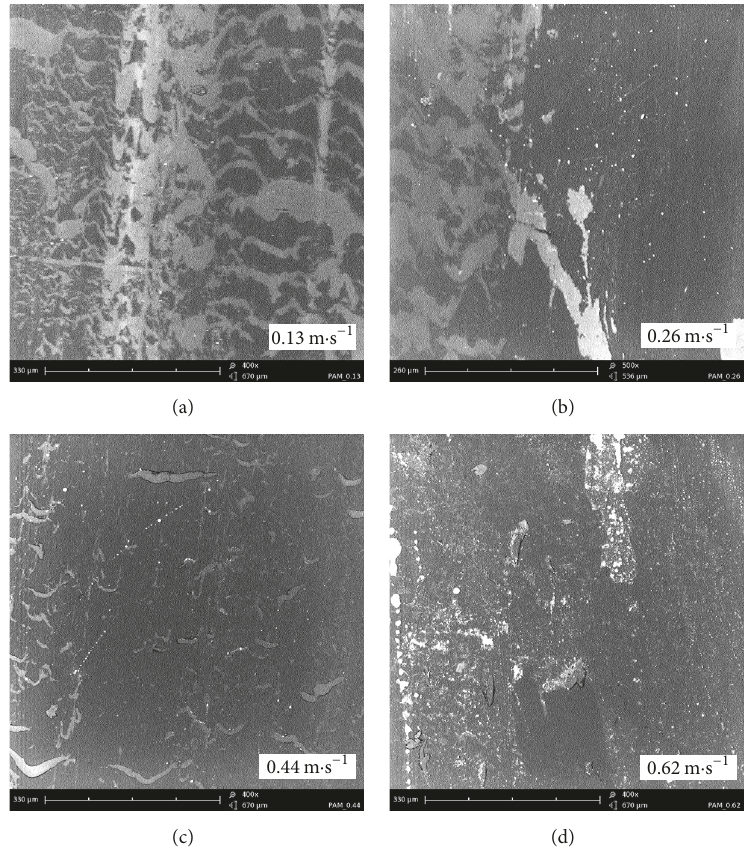
Figure 12: Effect of sliding velocity on worn surfaces of the investigated PA MoS 2 : ((a), (b), and (c)) surface with scale structure, composed of “roll-shaped particles” at various linear velocities, (d) plastic deformations in scaly zone,